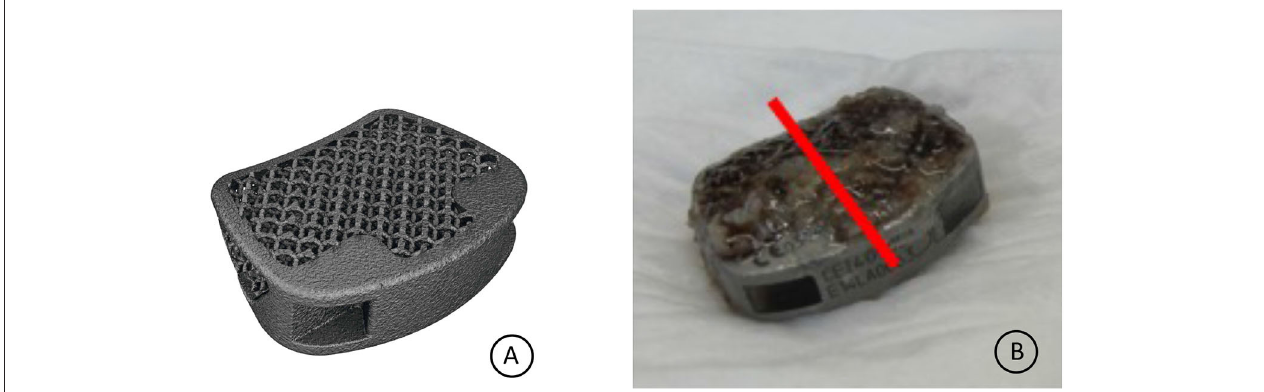
FIGURE 3 | (A) EIT cervical cage. (B) Retrieved cervical cage specimen. The red line indicates the intersection line from which the histological sections were cut.